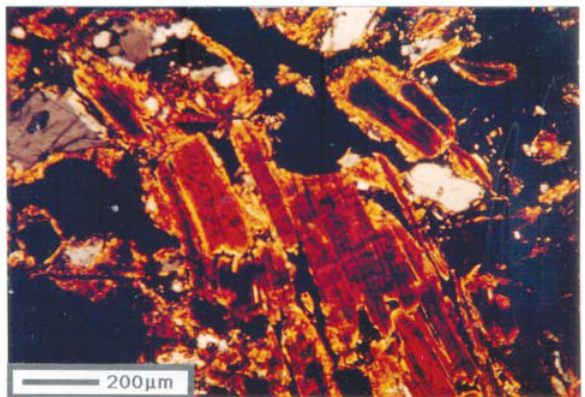
Figura 8. Micrografia do horizonte Crn do perfil 3 com nicois cruzados. Diversos estádios de intemperização de biotitas com produção de argilas. Muitos dos feixes de argila formados são similares aos encontrados nos horizontes